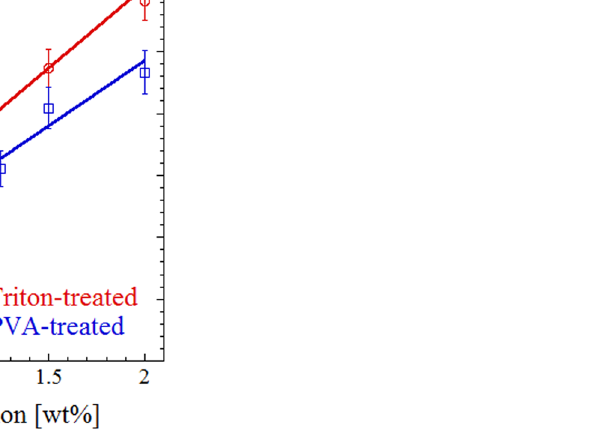
Figure 8. Room-temperature thermal conductivity of the porous composites as a function of CNT